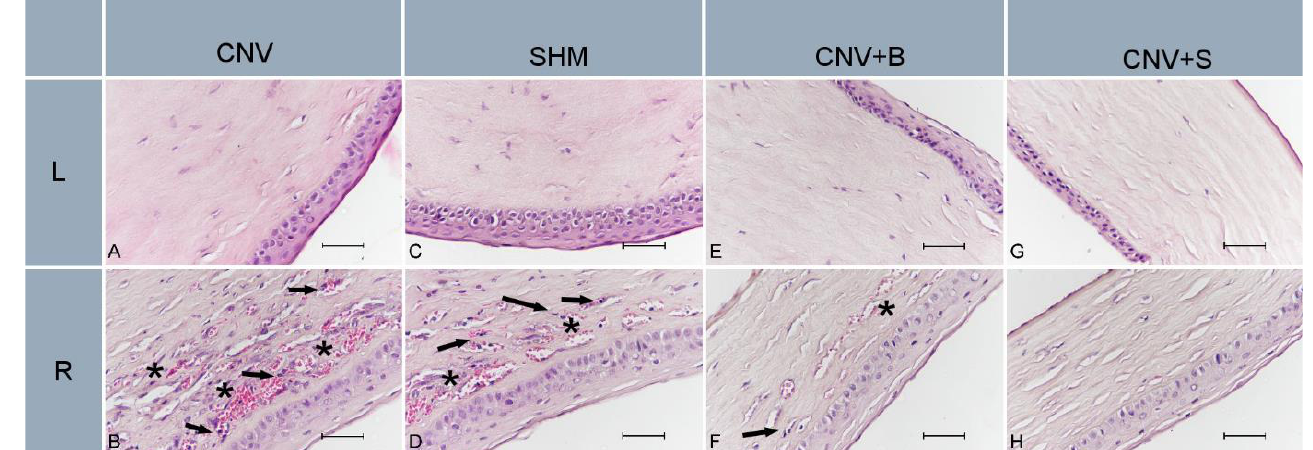
Table 1. The mean (± SD) results for histopathological findings in all groups. (Compared to CNV-